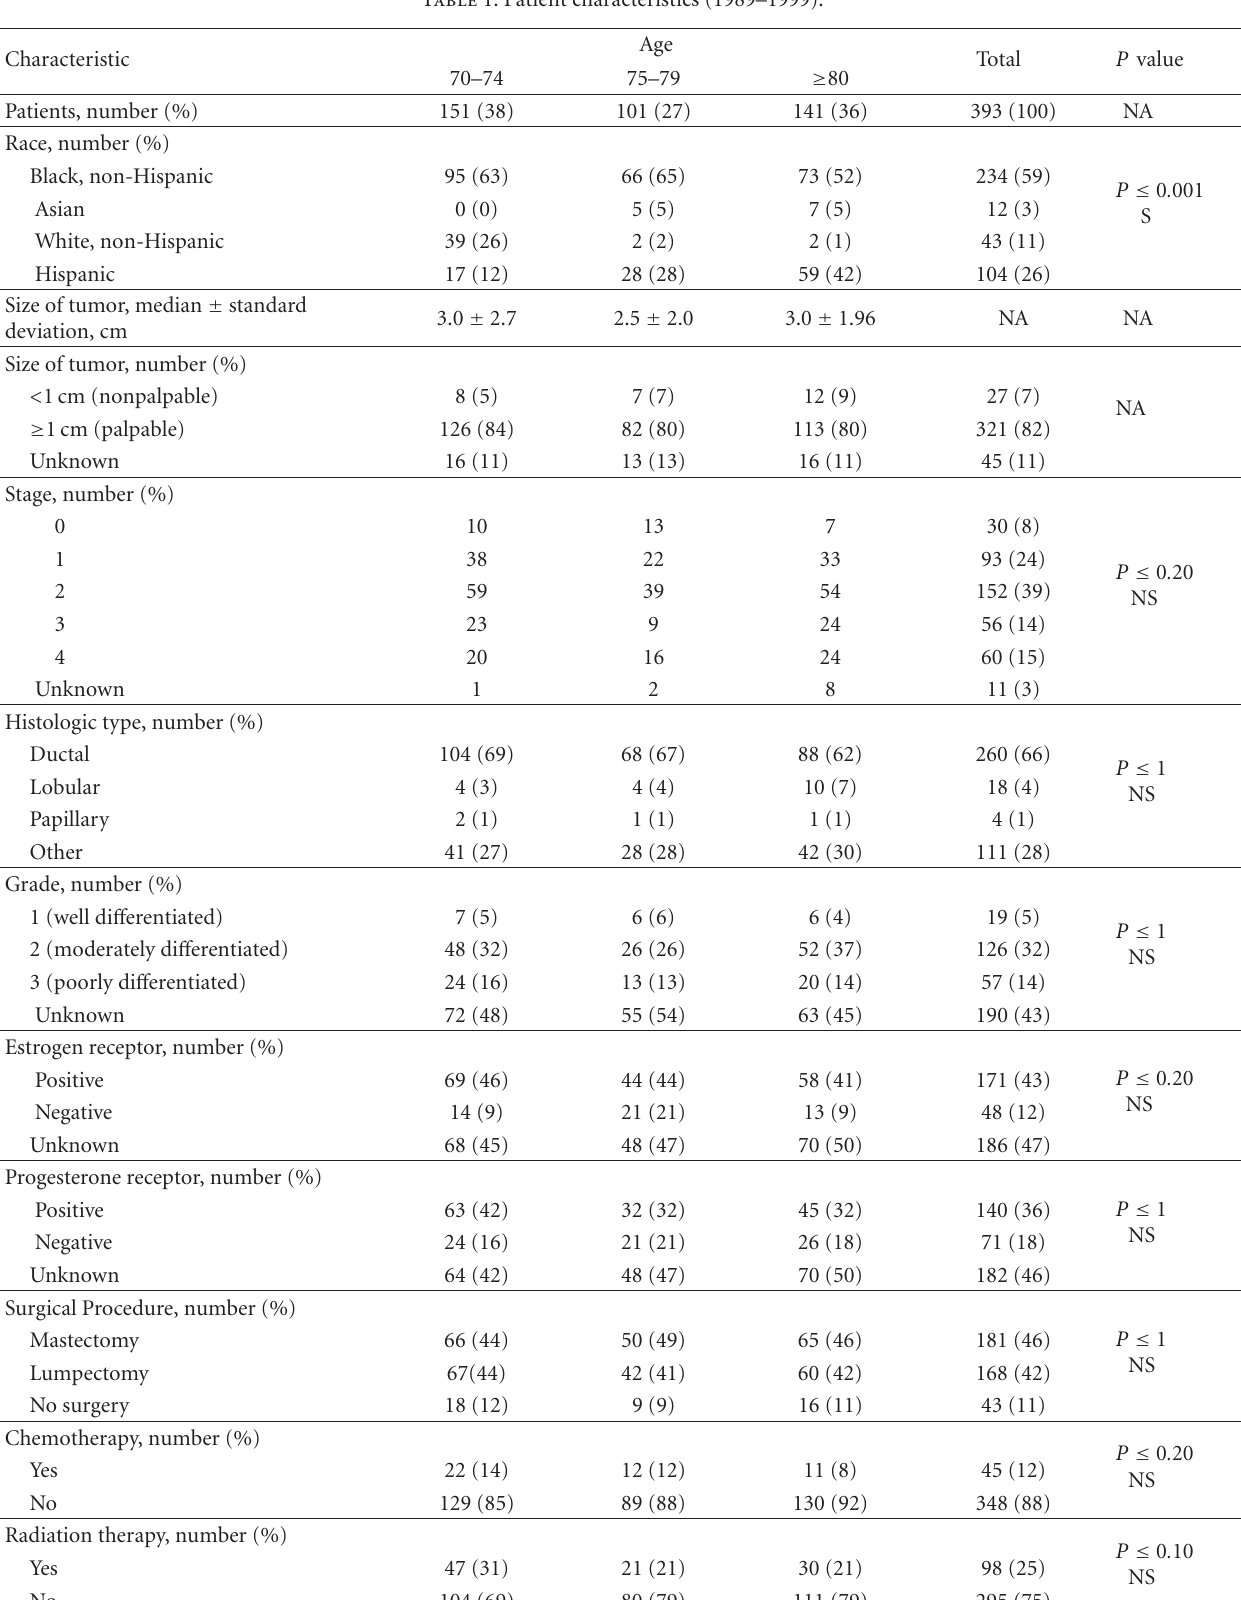
Table 1: Patient characteristics